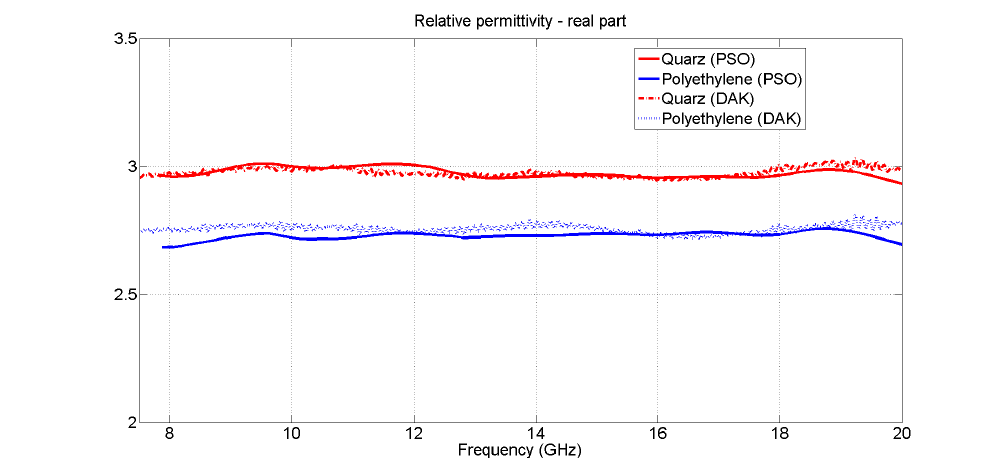
Figure 21. Comparison, from 8 to 20 GHz, between the values of the real part of the permittivity of quartz fiber (in red) and polyethylene (in blue), PSO and OECP (DAK Kit) methods.